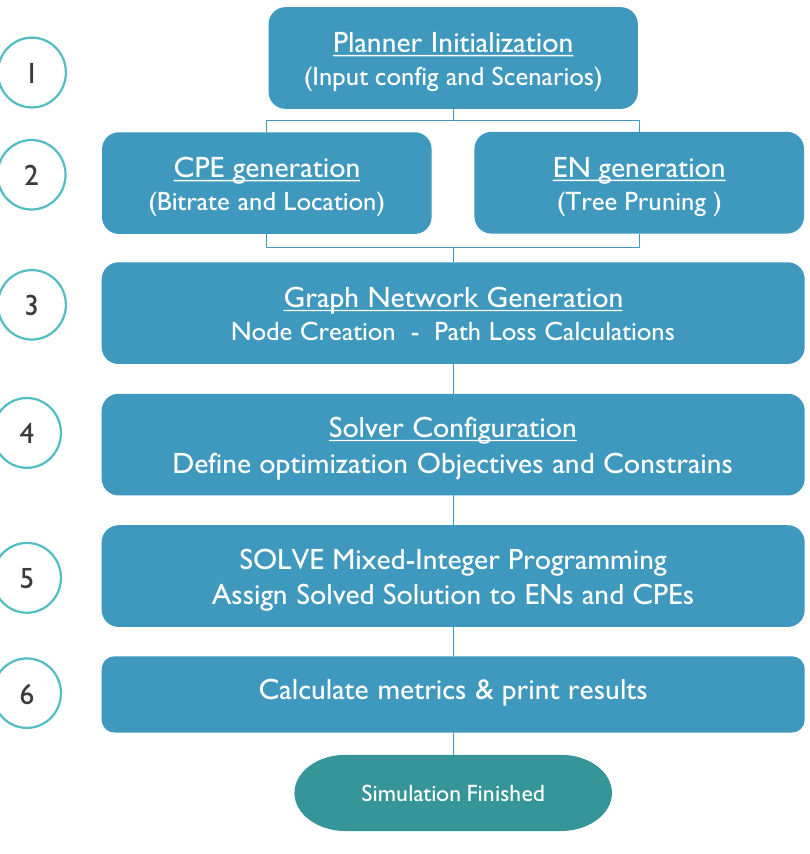
Figure 5. General network planning